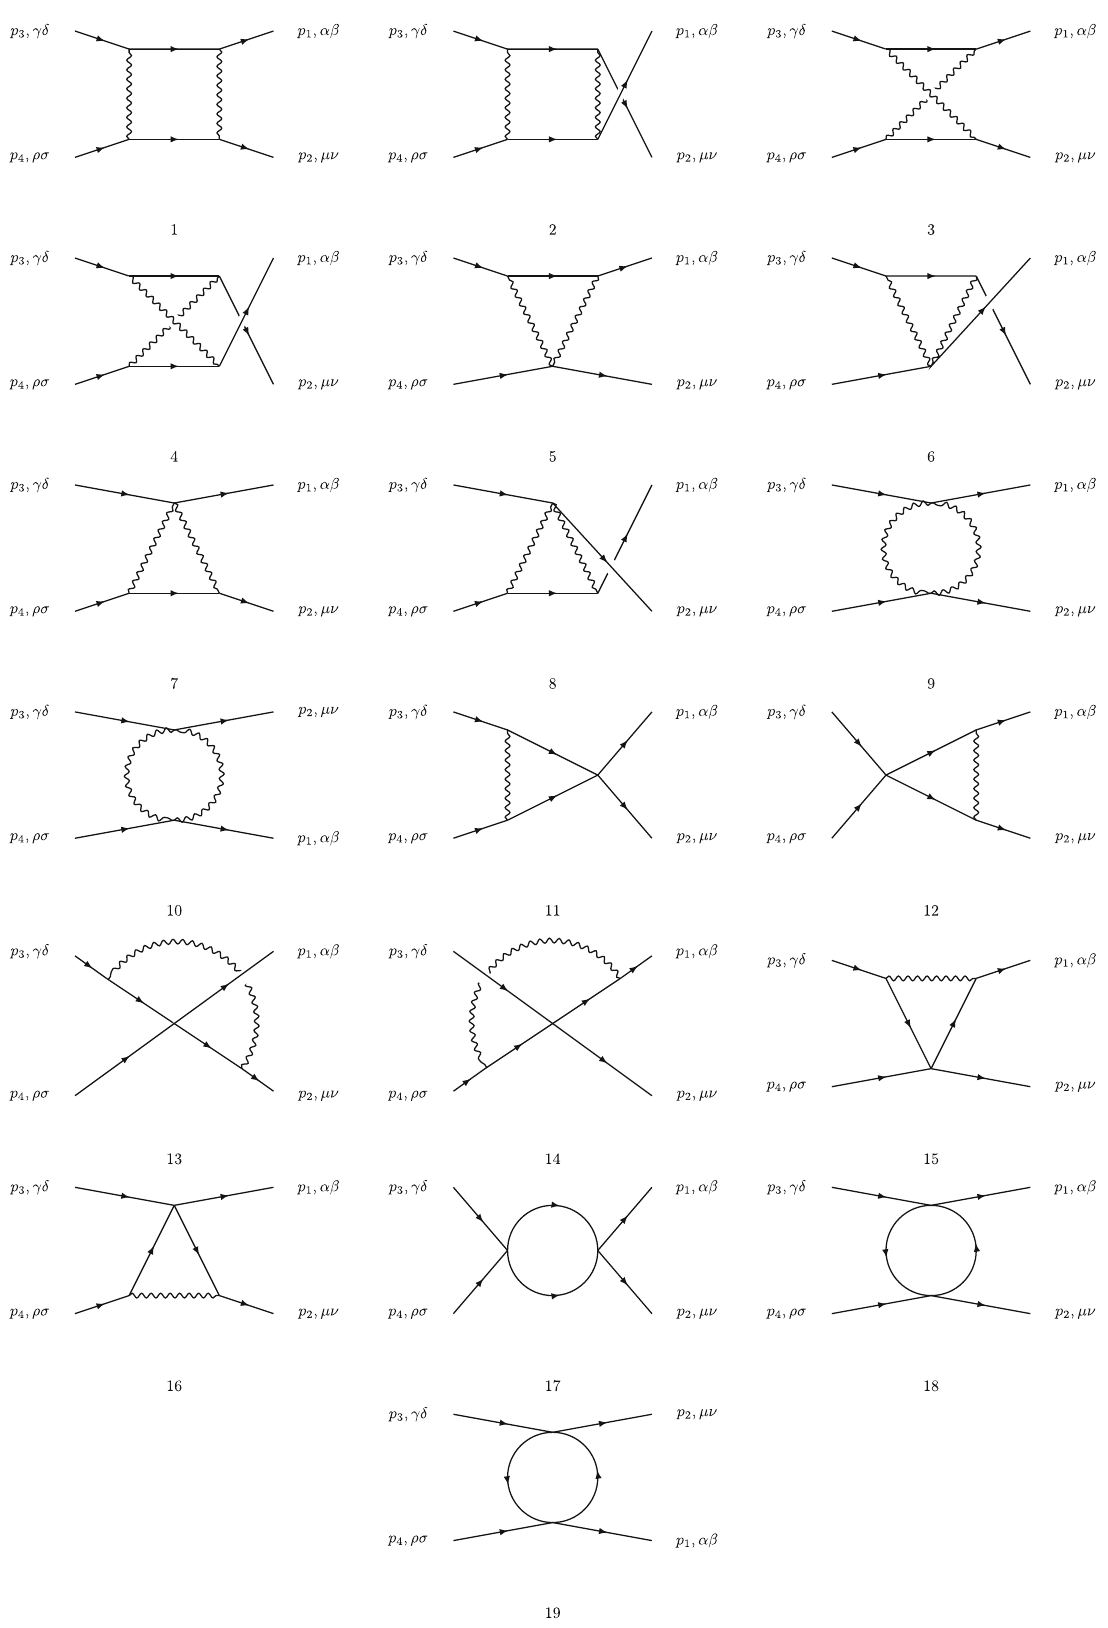
Fig. 9 Feynman diagrams for the TTTT vertex at